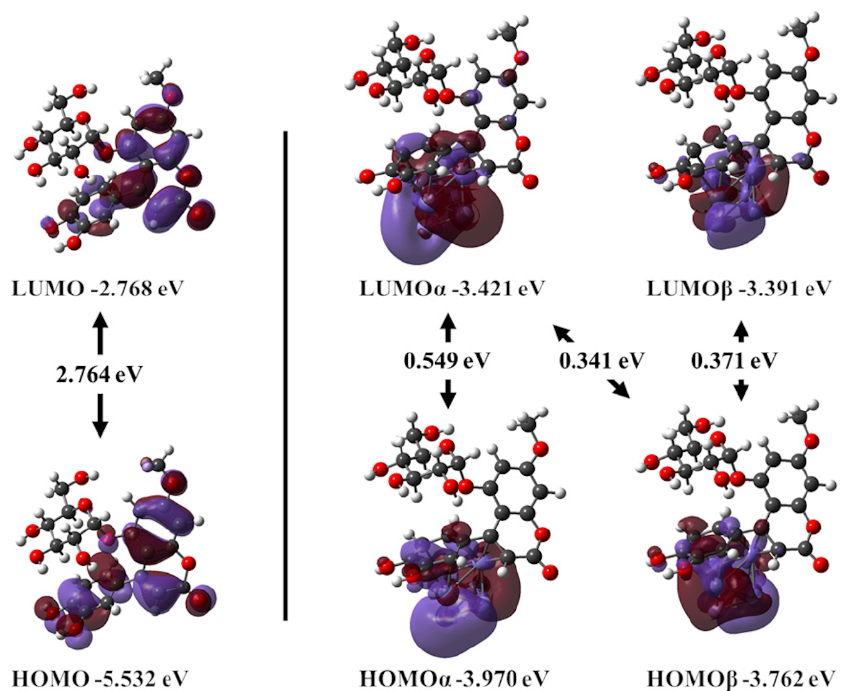
Figure 14. Frontier orbitals HOMO and LUMO of the 4-PC molecule ( left ) and Fe 6 + 4-PC ( right ), plotted on isosurfaces with 0.02 a.u. of the electron density. HOMO and LUMO, alpha and beta, calculated at the BPW91-D2/6-311++G(2d,2p) level. Table 3. Energetic and global parameters calculated for 4-PC, Fe 6 cluster, and their compounds. Values between parentheses are related to beta, spin down, orbitals.